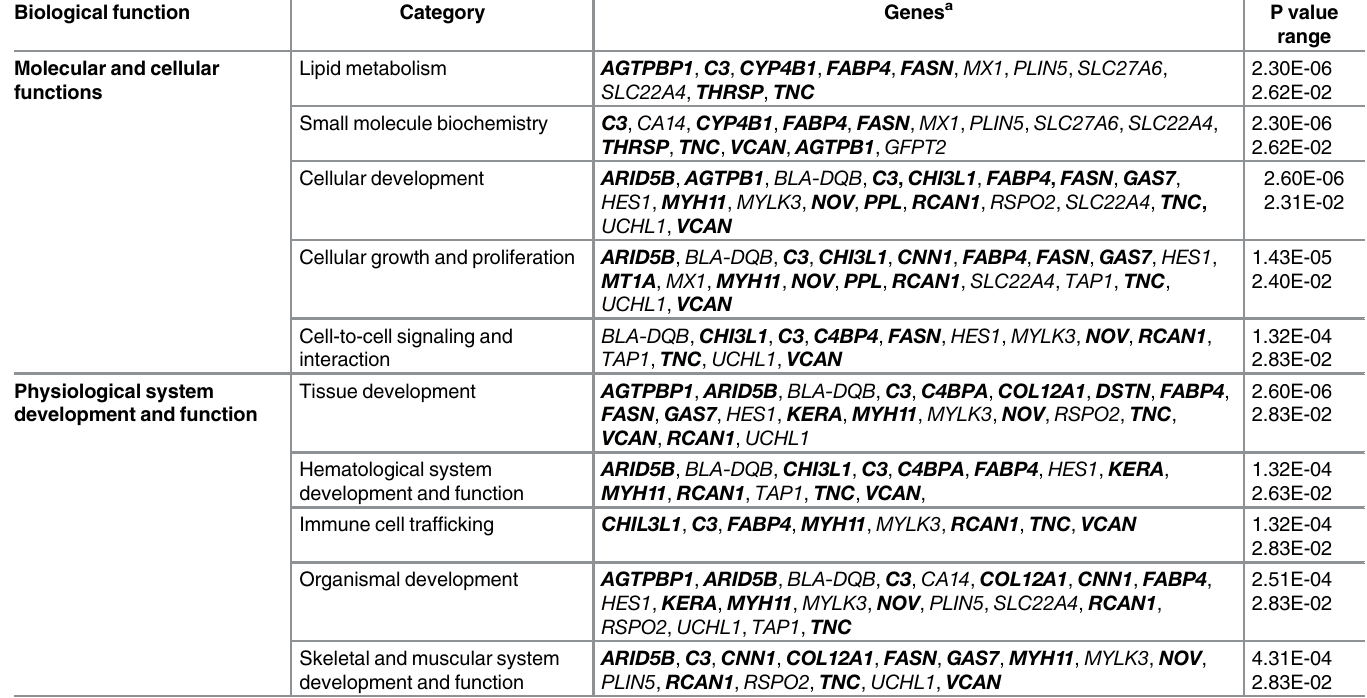
Table 5. Five main significant biological functions identified by IPA for the differentially expressed genes in the Longissimus dorsi muscle, com- paring high and low genomic breeding value groups for iron content in Nelore steers. Biological function Molecular and cellular